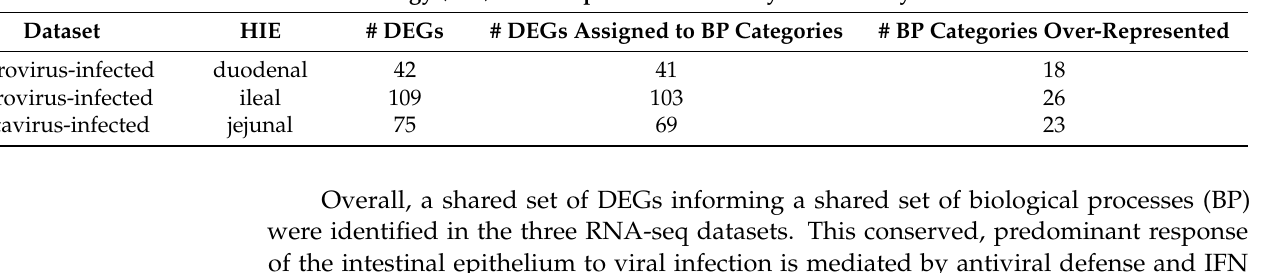
Table 3. Summary of Gene Ontology (GO) over-representation analysis. Over-representation analysis of biological processes (BP) was performed with the package ClusterProfiler in R on three published datasets of virus infected HIEs. An FDR cutoff of 0.1% (adjusted p value < 0.001) with the Benjamini–Hochberg (BH) step-up procedure was used to determine significantly over-represented BP. Listed are the total number of DEGs identified for each dataset as well as the number of DEGs that were assigned to a BP after over-representation analysis. For each dataset, the number of BP over-represented are also